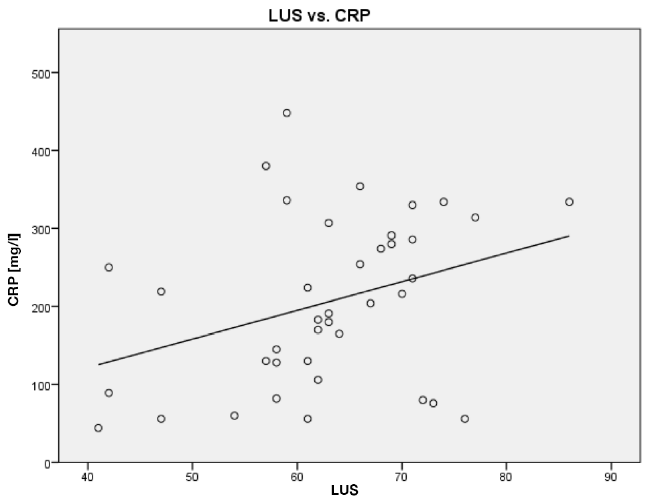
Figure 4. LUS score compared to C-reactive protein (CRP). Line of best fit is shown as a solid line.